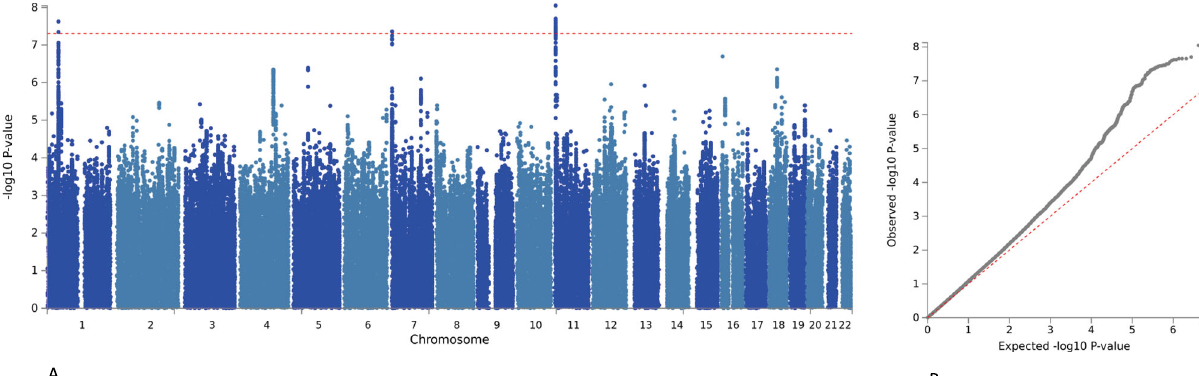
Fig. 1 Manhattan plot and quantile – quantile plot of results from the GWAS meta-analysis of ADHD + DBDs. A Results from GWAS meta-analysis of iPSYCH and PGC cohorts in total including 3802 cases and 31,305 controls. The x -axis represents autosomal chromosomes colored in light and dark blue. The y -axis represents two-sided P -values from meta-analysis using an inverse-variance weighted fi xed effects model. The red horizontal line represents the threshold for genome-wide signi fi cant association ( P = 5 × 10 − 8 ). B Quantile – quantile (q – q) plot with expected − log10 P -values on the x -axis and − log10 P -values from the GWAS meta-analysis on the y -axis. The dotted line indicates the distribution under the null hypothesis.